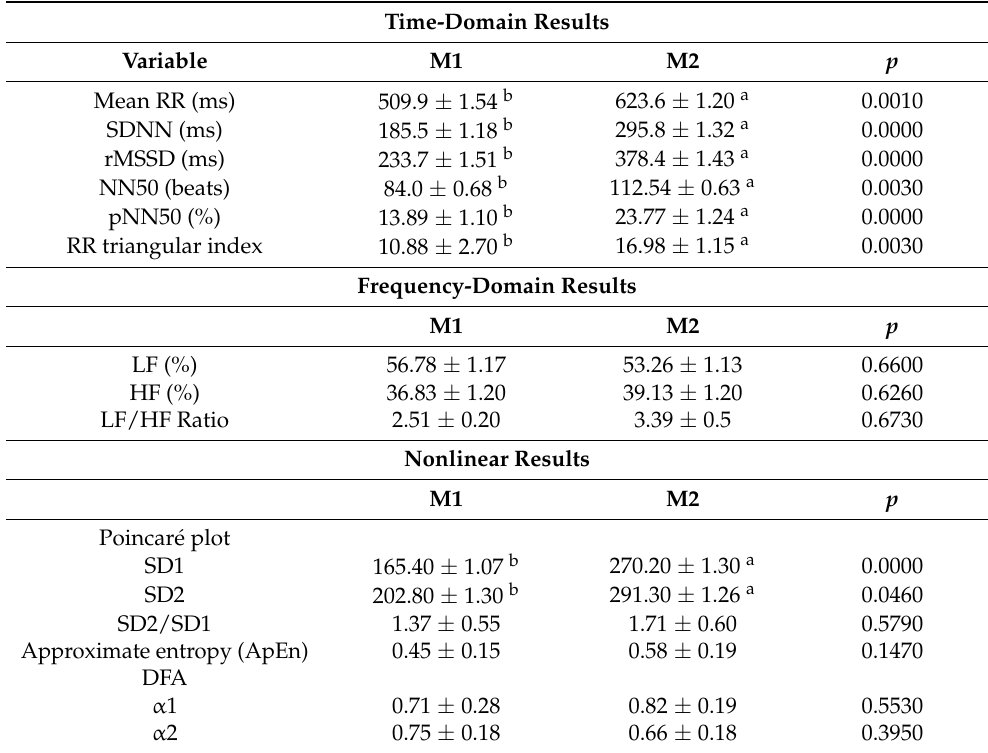
Table 5. Heart rate variability measured in the dressage simulation tests used to evaluate a 6-week training protocol for Lusitano